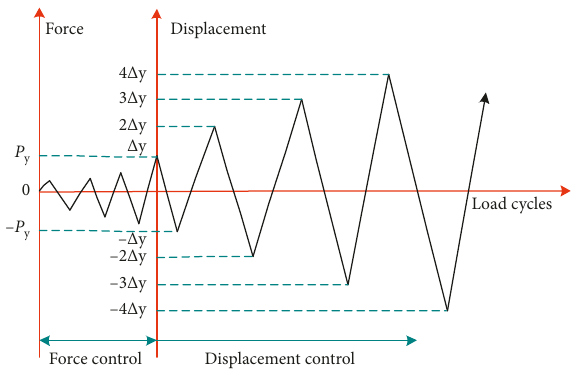
Figure 4: Test loading